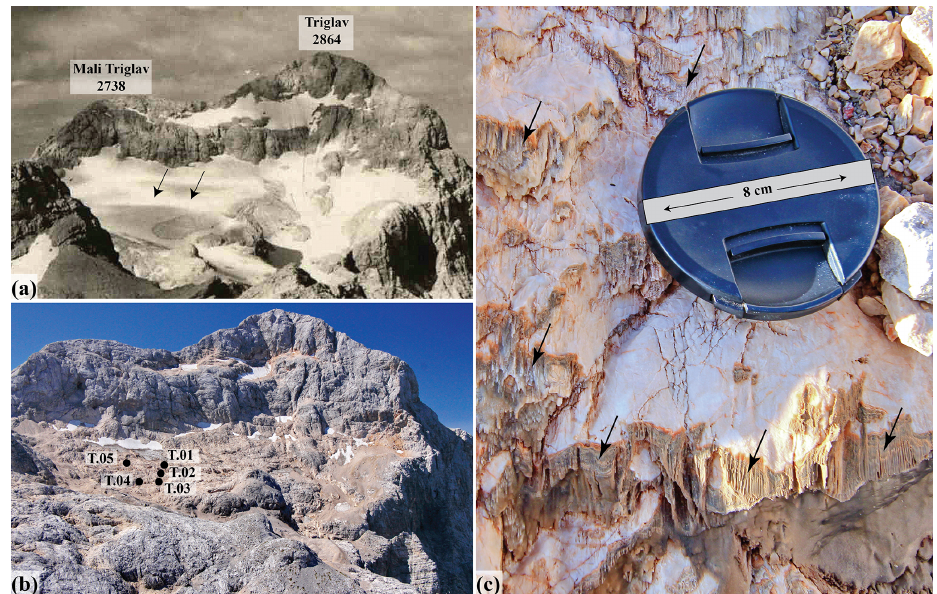
Figure 1. Mount Triglav, the Triglav Glacier and the sampling location of subglacial carbonates relative to the years 1932 ( a ; arrows) and 2017 ( b ; dots). Close-up of the exposure of subglacial carbonate ( c ); arrows point to fluted subglacial carbonate, attached to the lee side of the Upper Triassic limestone. Note the colour change between the bedrock surfaces: greys (longer exposure) versus beige and brown on the recently exposed surfaces. This has often been explained by microbial activity (Dias et al., 2018). Photos courtesy of ( a ) Janko Skerlep (© ZRC SAZU Anton Melik Geographical Institute archive), ( b ) Miha Pavšek and (c) Matej